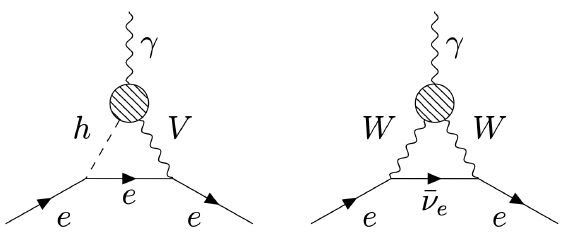
Figure 2 . Contributions to the electron EDM from the Barr-Zee diagram induced by the vector- like leptons.